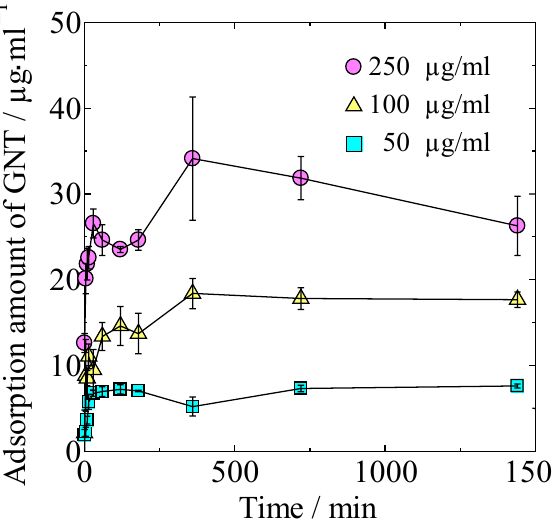
Figure 2. Adsorption isotherms at different concentrations of GNT.